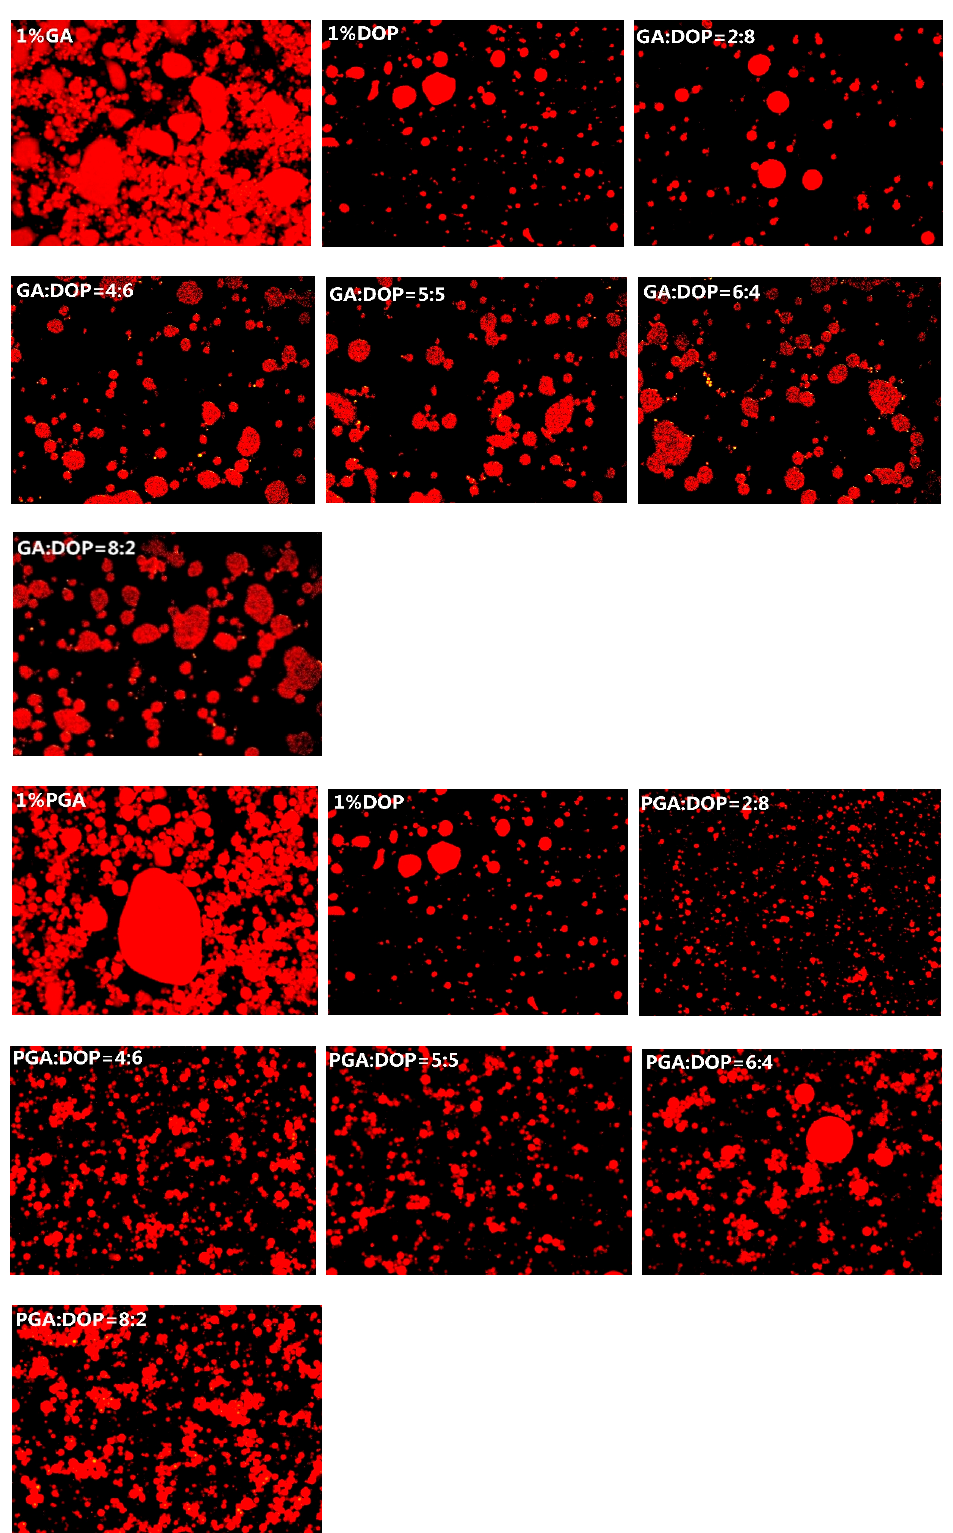
Figure 5. The microstructure of emulsions prepared by compounding polysaccharides of PGA and DOP or compounding polysaccharides of GA and DOP as emulsifiers (total emulsifier concentration was 1 wt%).